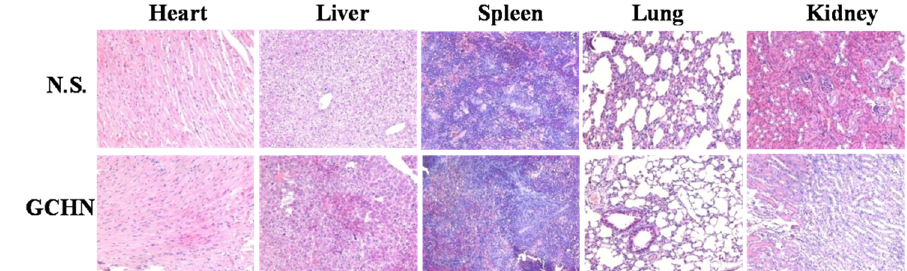
Figure 9. Histological assessment results (200×) for control and GCHN. No signs of tissue damage, inflammation, or lesions were observed in representative